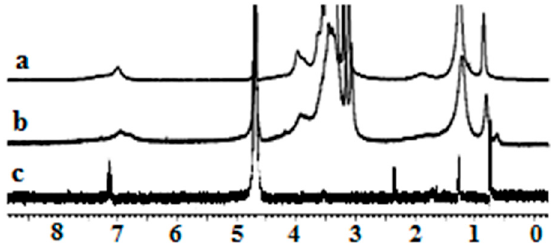
Figure 9. 1 H-NMR spectra of ( a ) 1a , ( b ) the 1a + NAP complex, and ( c ) NAP in D 2 O [ 1a ] = [NAP] = 1.0 × 10 − 4 mol/L in all tests. Figure 10. 1 H-NMR spectra of ( a ) 1a , ( b ) the 1a + IBP complex, and ( c ) IBP in D 2 O [ 1a ] = [IBP] = 1.0 × 10 − 4 mol/L in all tests.